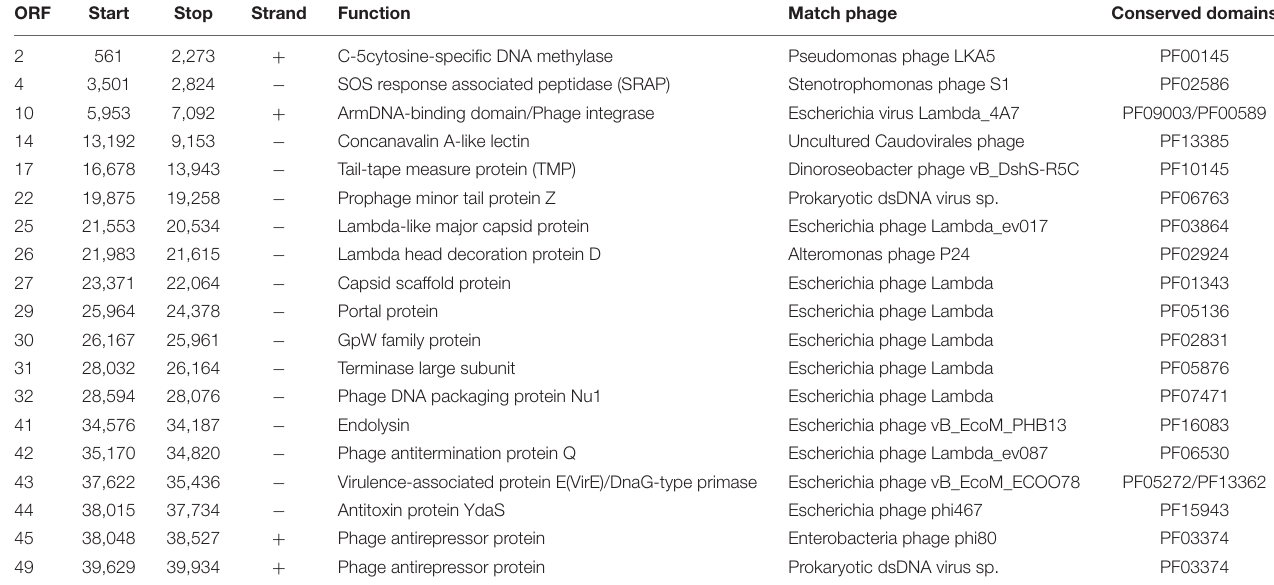
TABLE 2 | The conserved domains detected of